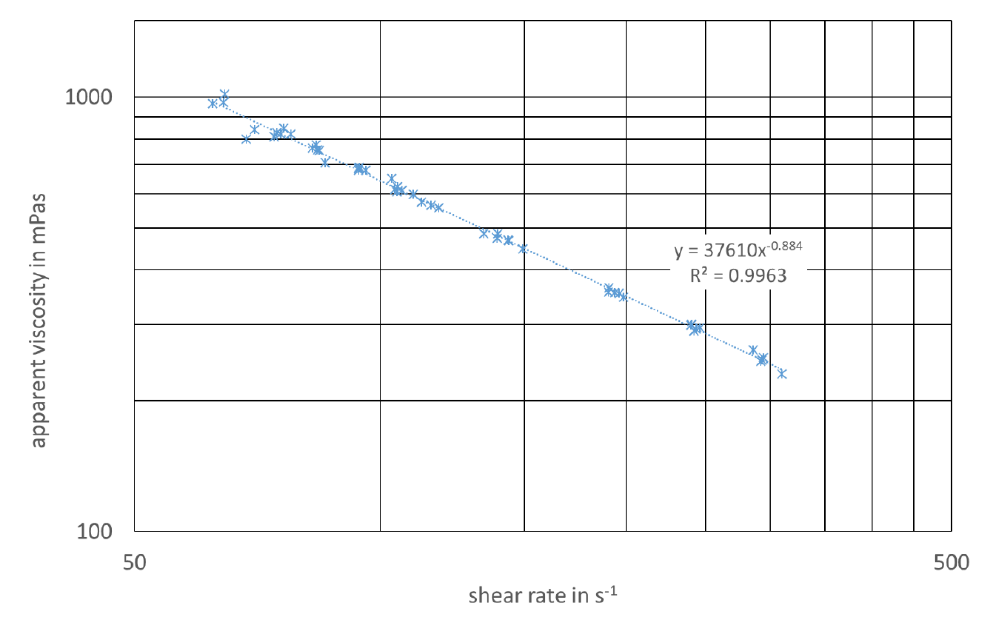
Figure 6. Flow diagram, digester 3.1 / with enzyme application and regression parameters.